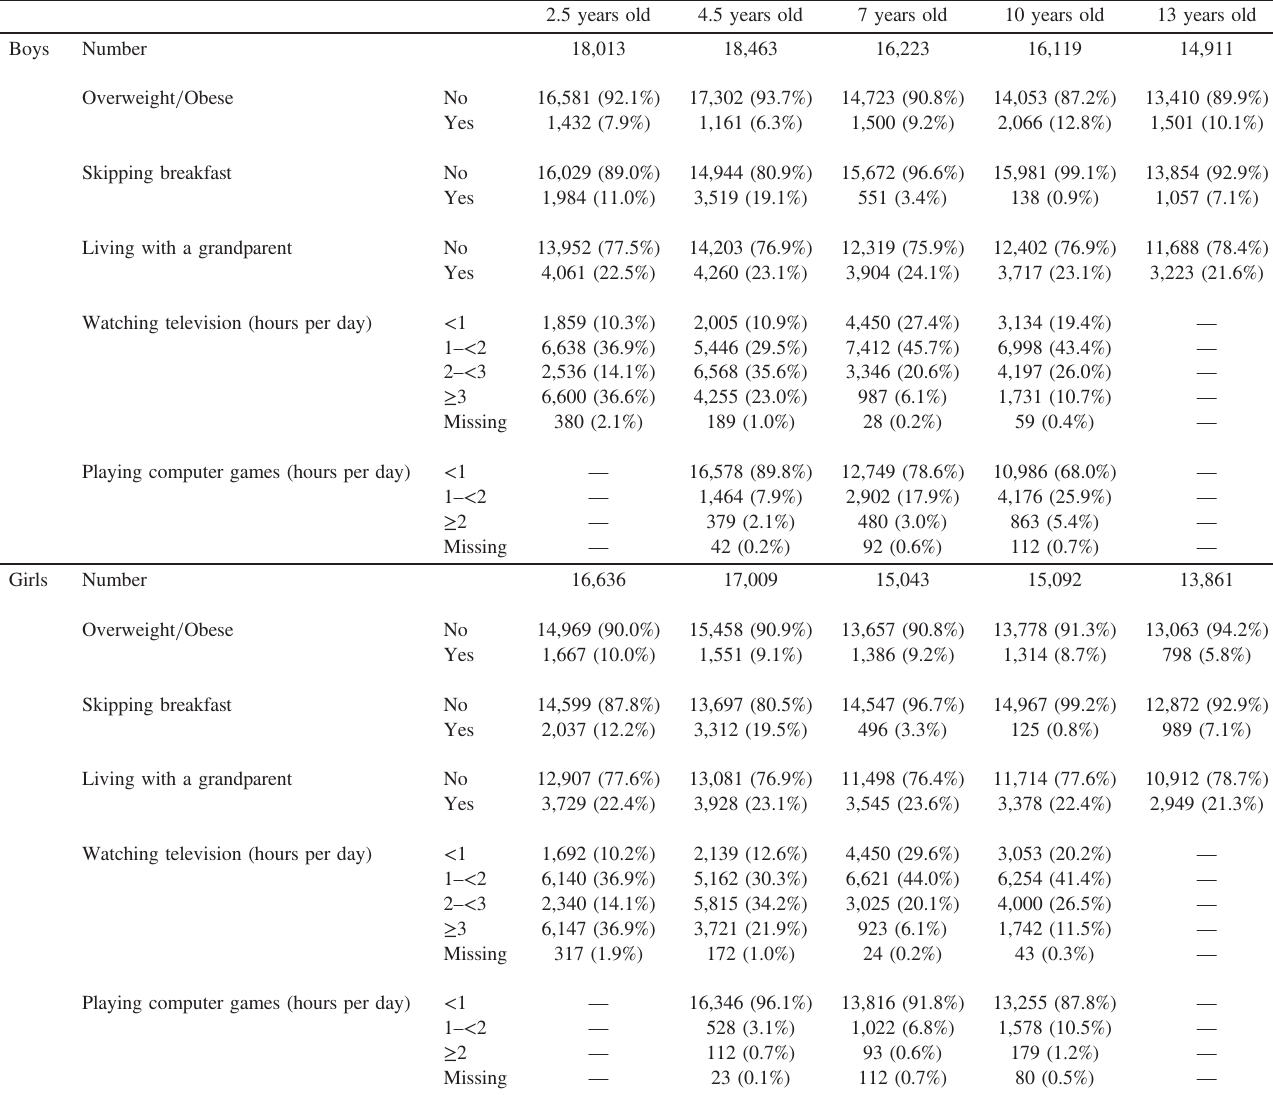
Table 2. Time-varying factors of study